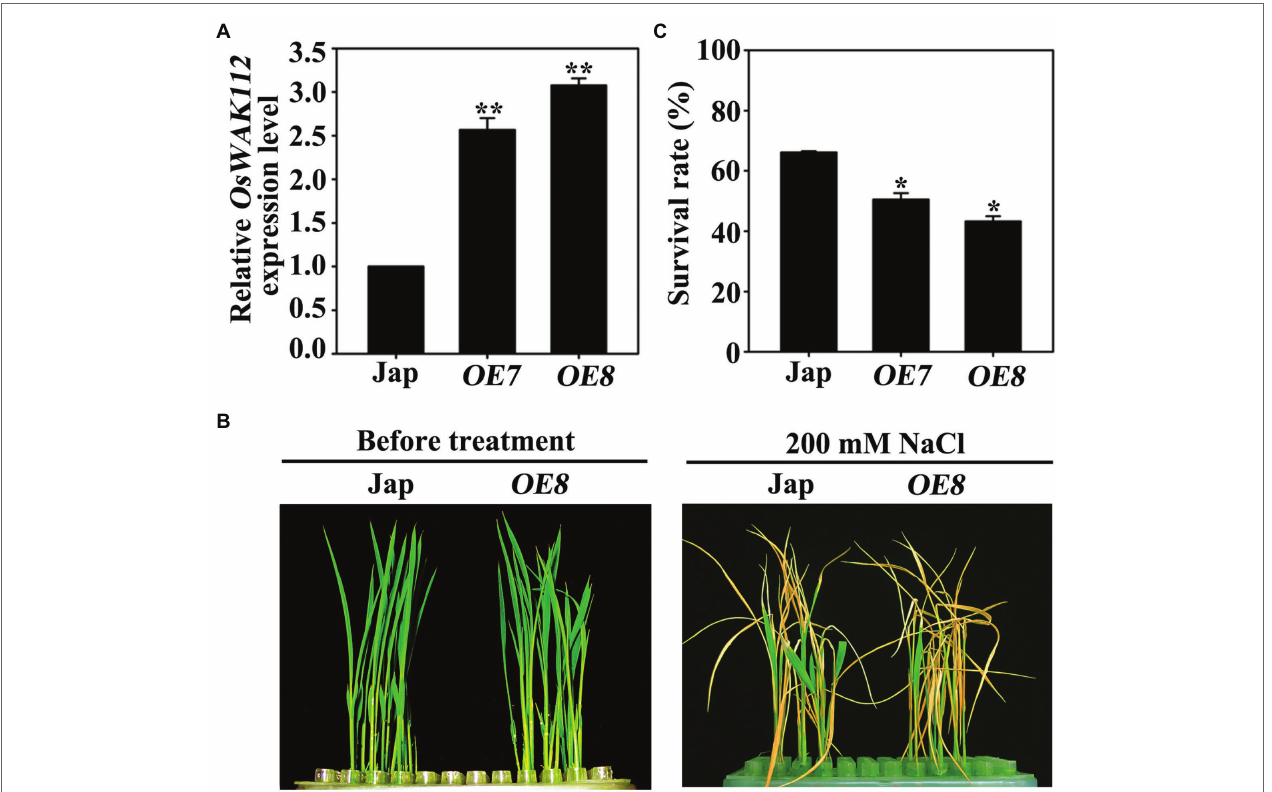
FIGURE 1 | Phenotypes of the OsWAK112OE lines under salt stress. (A) The OsWAK112 transcript levels in 7-day-old Jap and OsWAK112OE lines as determined by RT-qPCR. (B) A comparison of the phenotypes of Jap plants and a representative OsWAK112OE line ( OE8 ) before and after salt treatment. Ten-day-old seedlings were used as described in the Materials and Methods. (C) Survival rates of Jap and two individual OsWAK112OE lines following salt exposure. In (A,C) , each data point represents the mean ± standard error (SE) from three biological repeats ( n ≥ 50). Asterisks indicate a difference relative to Jap (Student’s t -test, * p < 0.05 and ** p <